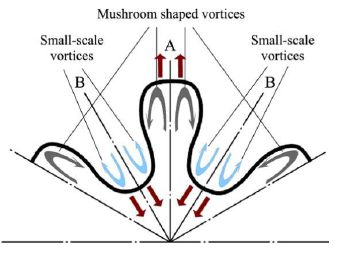
Fig.6 Vortex formation.